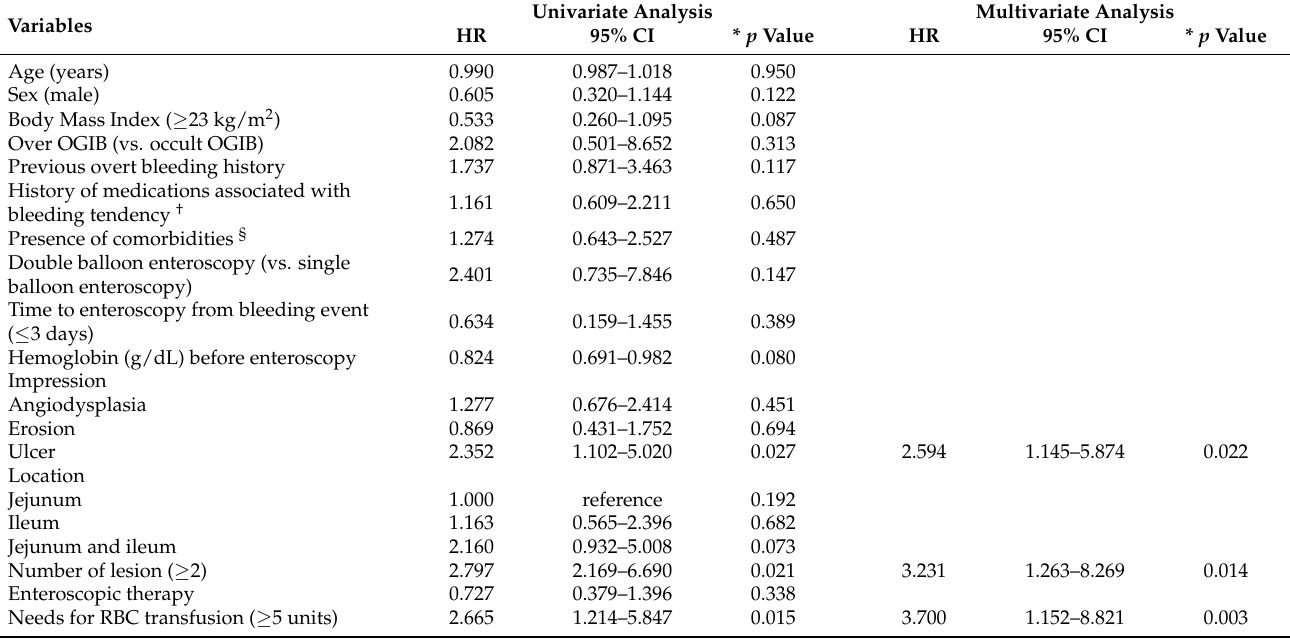
Table 2. Factors associated with rebleeding following endoscopic therapy of small bowel lesions with device-assisted